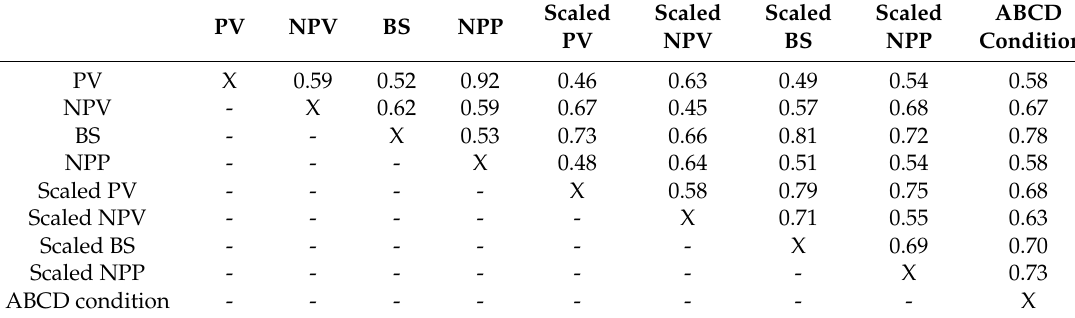
Table 5. Comparison of kappa values for maps of seasonal components of fractional cover, seasonal NPP, scaled components of fractional cover, scaled NPP, and the Karfs et al. [43] ABCD condition in the Burdekin Dry Tropics. Comparisons were made with the fuzzy kappa statistic [47] applied to each pair of maps taken as a whole, hence the single value for each